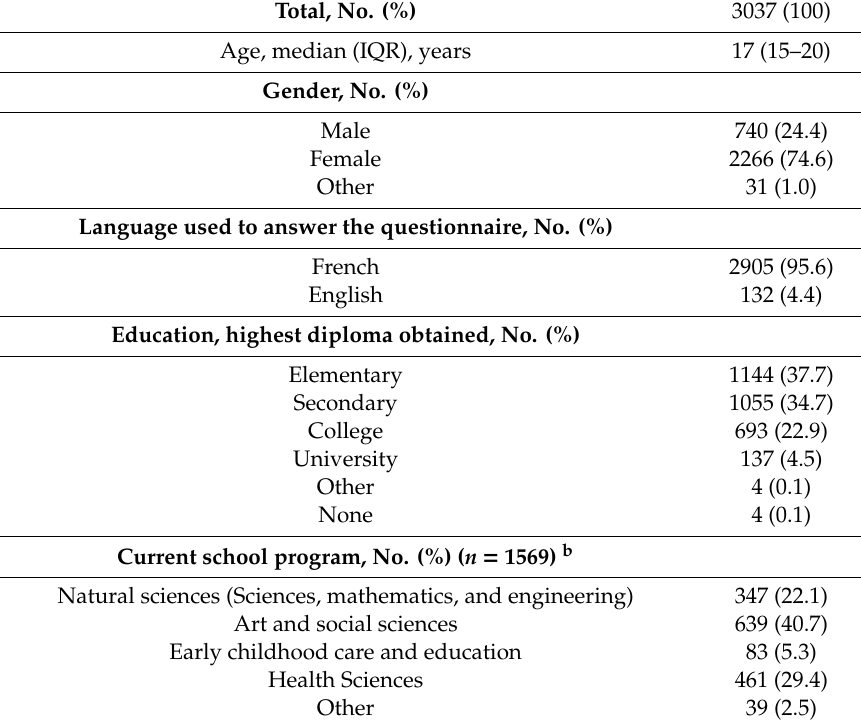
Table 1. Participant characteristics a